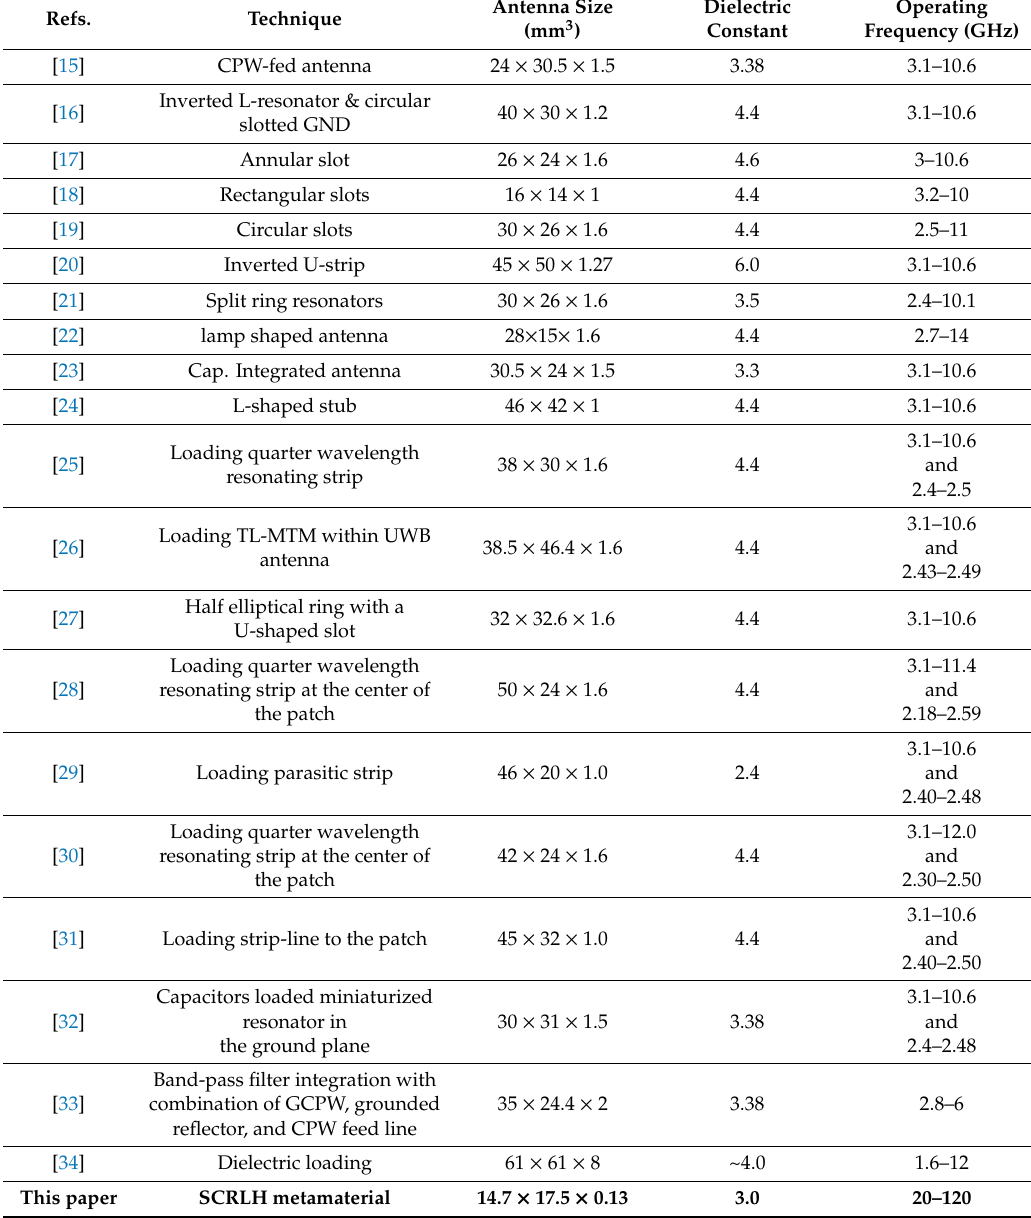
Table 3. Comparison with recently reported